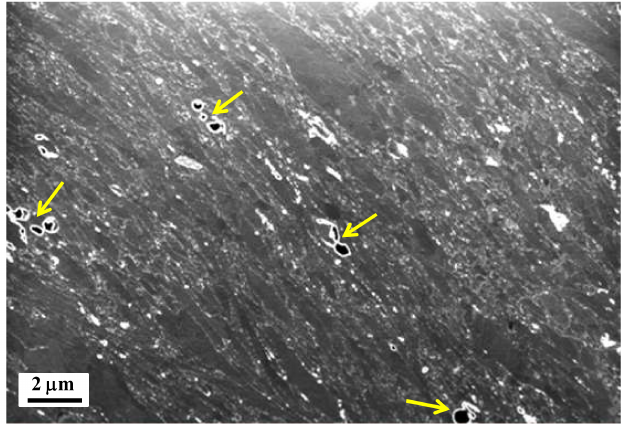
Figure 4. In-situ focused ion beam (FIB) micrograph of the nano-HPT product recorded during the foil preparation for TKD measurements. Arrows indicate the vacancies left after 2 turns HPT